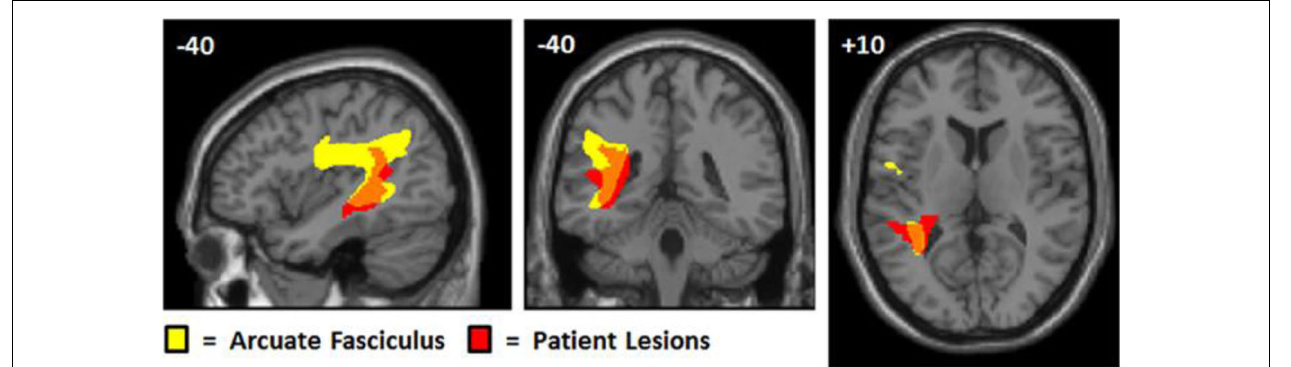
FIGURE 5 | Overlap between patient lesions and arculate fasciculus. This figure shows the arcuate fasciculus (yellow) from Ffytche etal.’s (2010) probabilistic atlas with the lesion overlap map for our patients, positioned at MNI co-ordinates ( − 40, − 40, + 10).The probabilistic tractography image was thresholded at 0.25 and the lesion overlap map was thresholded to show areas where damage overlapped for at least four patients. Although the lesion